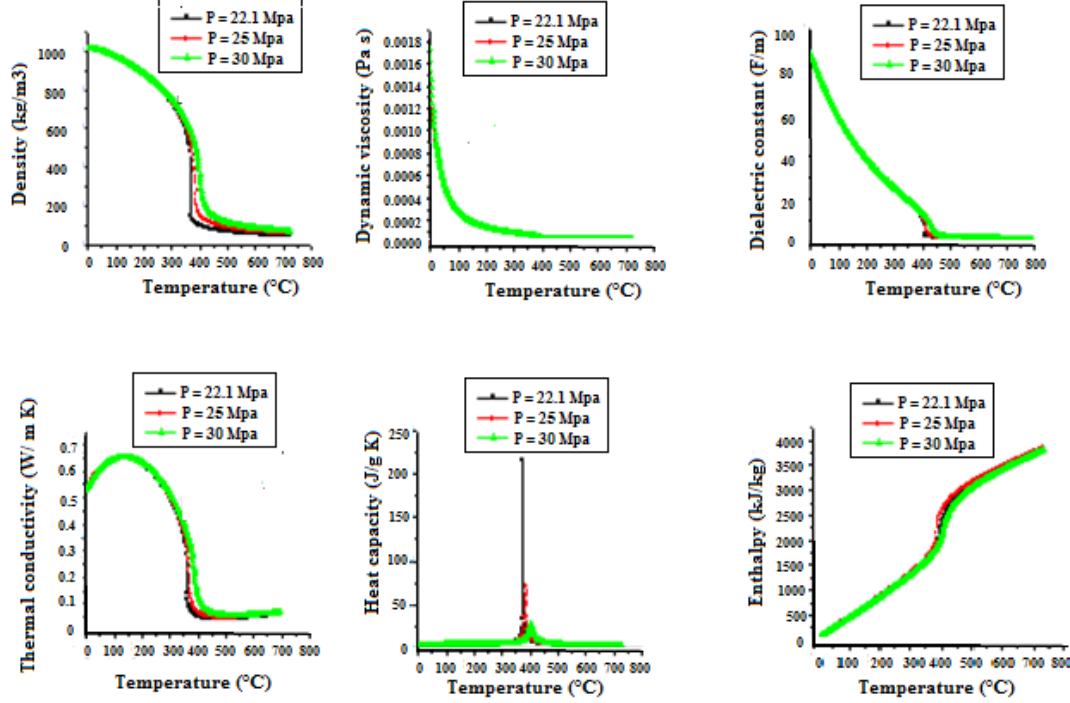
Figure 3. Properties of water around supercritical conditions.